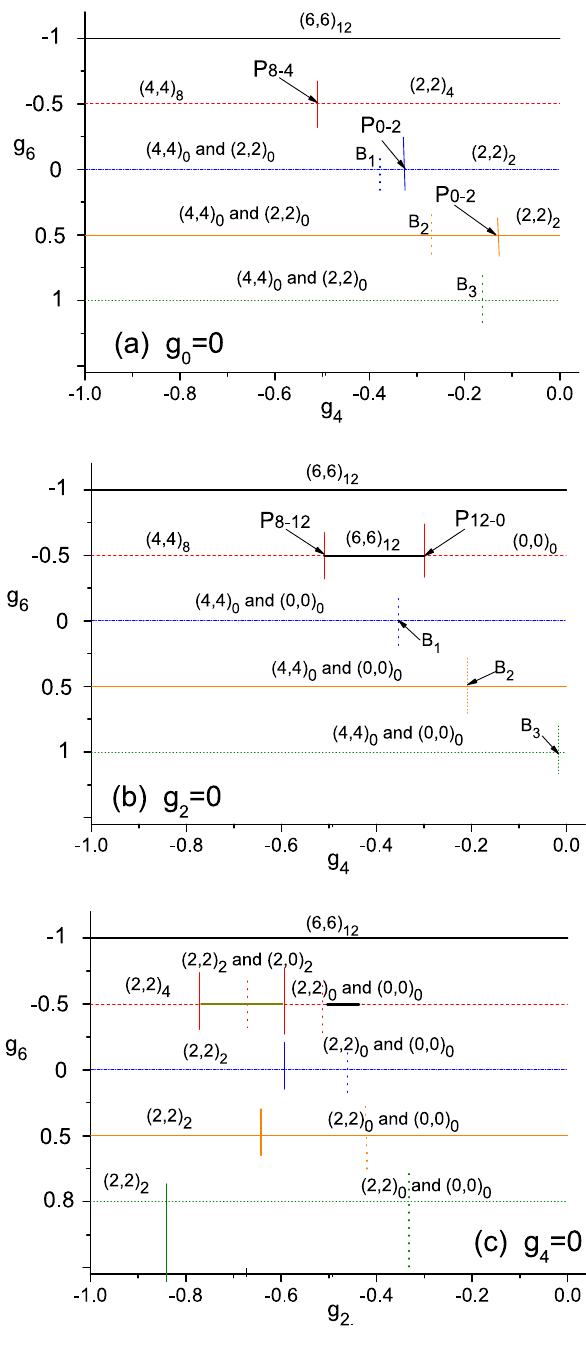
Figure 2. The dominant component(s) in the spin-structure of the g.s. The label of the component ( (cid:31) a , (cid:31) b ) S is marked above the horizontal lines, each is for a given g 6 marked at the left end of the line. For 2a, g 0 abscissa is for g 4 , and g 2 the abscissa is for g 2 , and g 0